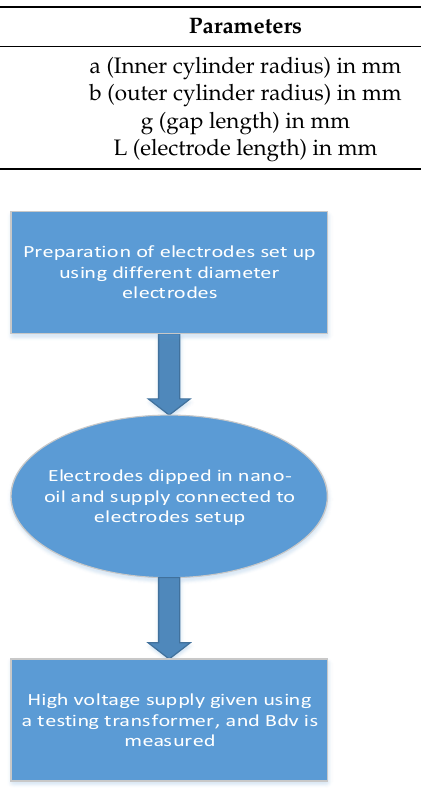
Figure 3. Steps involved in the experimental procedure. The gap length (g) is varied by using the inner electrodes having a different diameter, and the diameter of the outer electrode is kept fixed. Hence for each fixed length we will get four different gap lengths. Figure 4a shows the different electrodes used in the